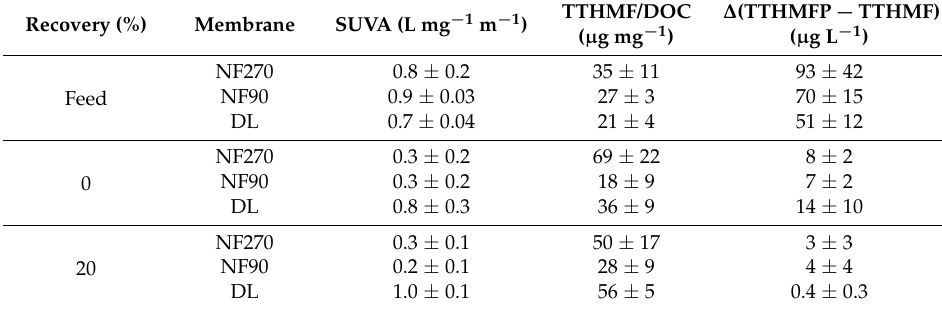
Table 3. Average values of SUVA, TTHMF/DOC, and Δ (TTHMFP − TTHMF) measurements for NF270, NF90, and DL as a function of recovery.